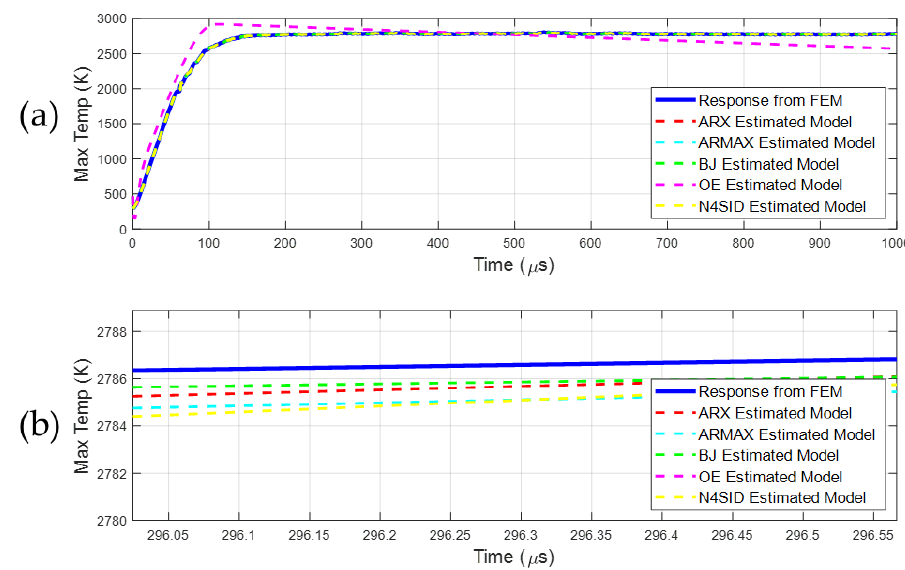
Figure 9. Estimated systemic models. The solid line indicates the initial measurement from FEM, dashed line indicates the estimated models ( a ), close-up of systemic models ( b ).